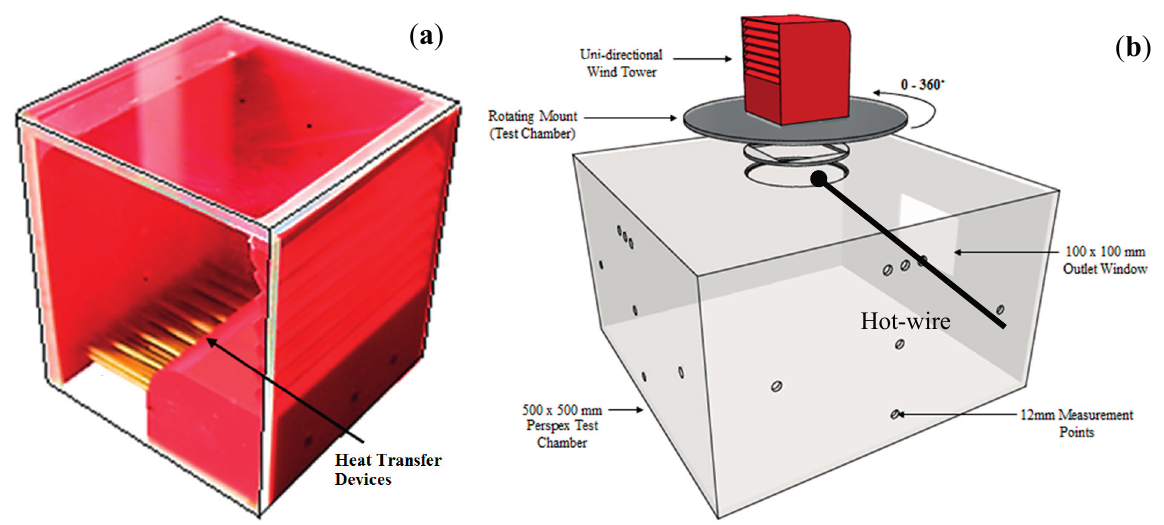
Figure 12. ( a ) 1:10 wind tower prototype; ( b ) Test room prototype.